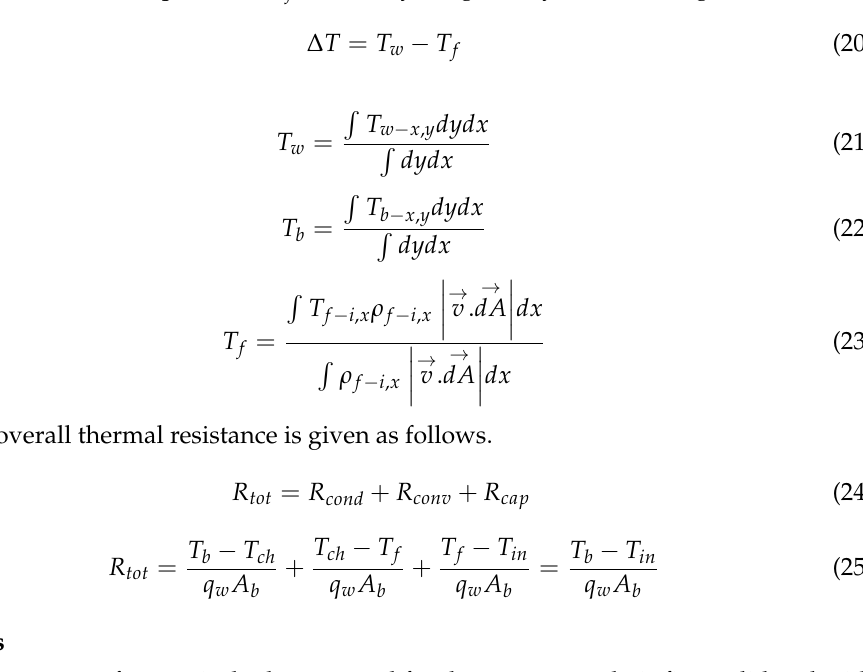
( b ) Figure 2. Validation of ( a ) Nusselt number and ( b ) friction factor with Wang et al. [21]. 3.2. Characteristics of Temperature and Pressure Distribution The temperature distribution for MCHS with trefoil shaped ribs was added to the base wall (BWTR), sidewall (SWTR) and all wall (AWTR) cases together with the smooth channel, which is shown in Figure 3. This was performed in order to study the tempera- ture distribution (cooling) with the addition of trefoil shape ribs. MC-AWTR case showed better cooling in terms of temperature drop followed by MC-SWTR and MC-BWTR, re- spectively.